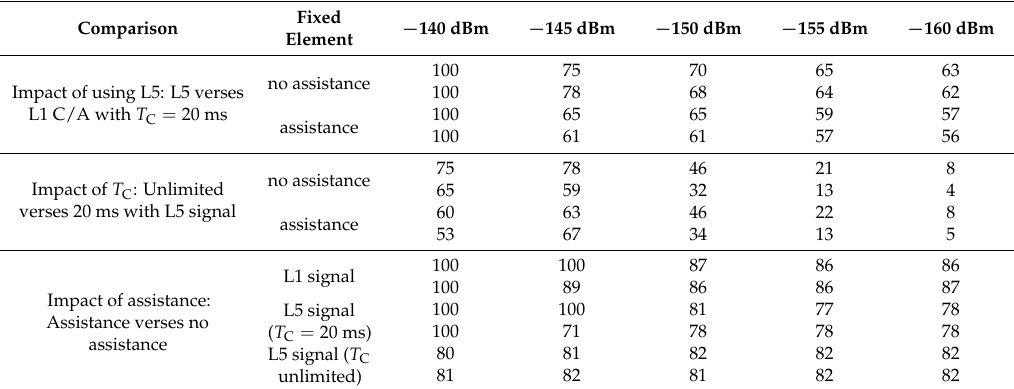
Table 7. Ratio of total integration time (%) for different comparisons with GPS signals. Top value is for average losses, and bottom value is for worst losses. Note that the sensitivities given are for the L1 C/A signal; those of L5 are 1.5 dB